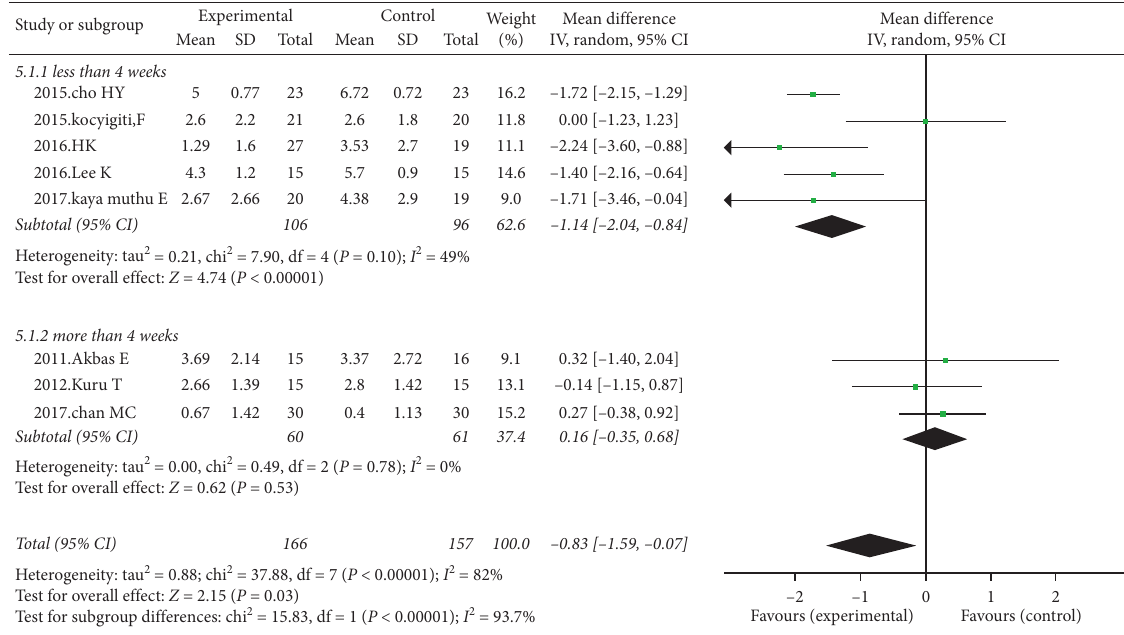
Figure 2: Effects of Kinesio Taping on chronic knee pain. Subgroup analysis: those studies in which the measurement was performed at less than 4 weeks are compared with the remaining 3 studies in which the assessments were performed at the six-week end in pain reduction.